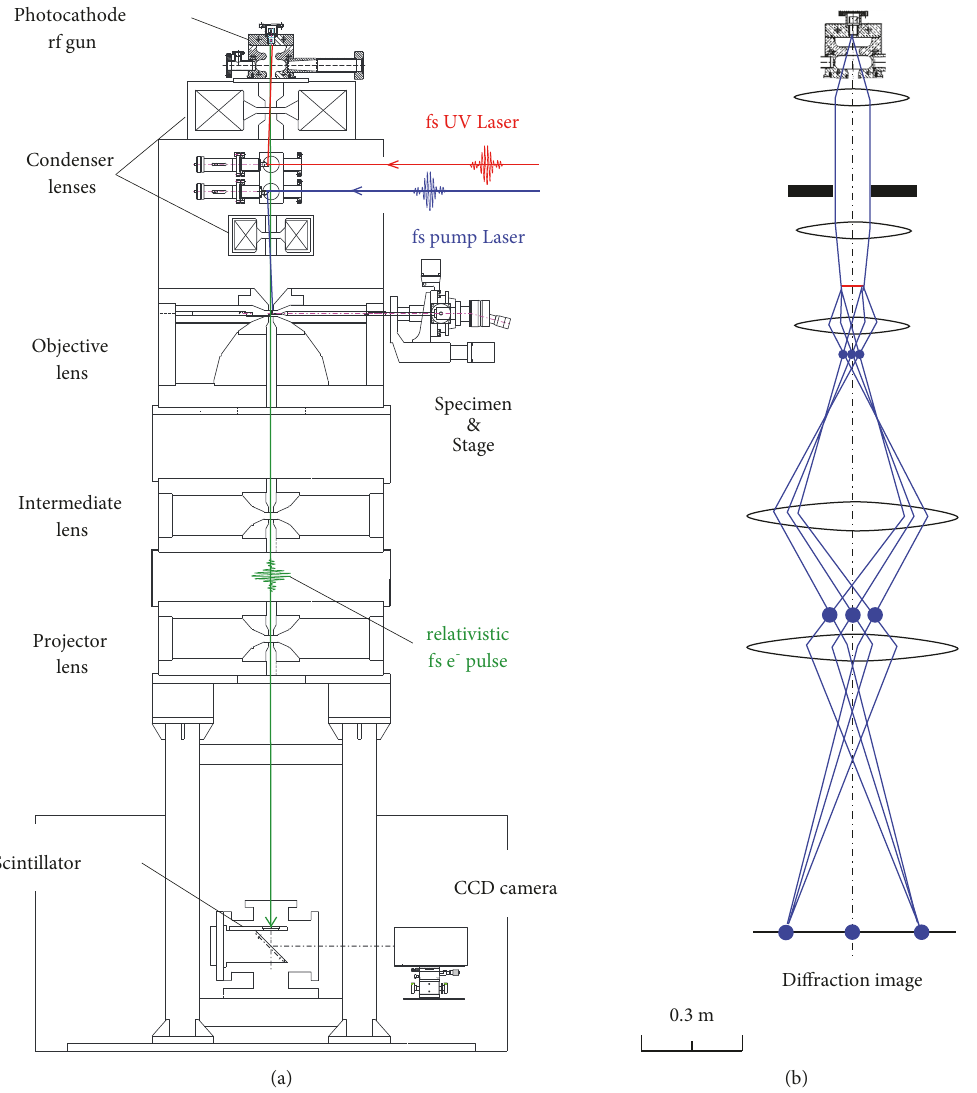
Figure 1: Prototype relativistic UEM with MeV femtosecond electron pulses generated by a photoemission rf gun: (a) cross-sectional schematic of prototypical UEM [1] and (b) ray diagram for electron diffraction